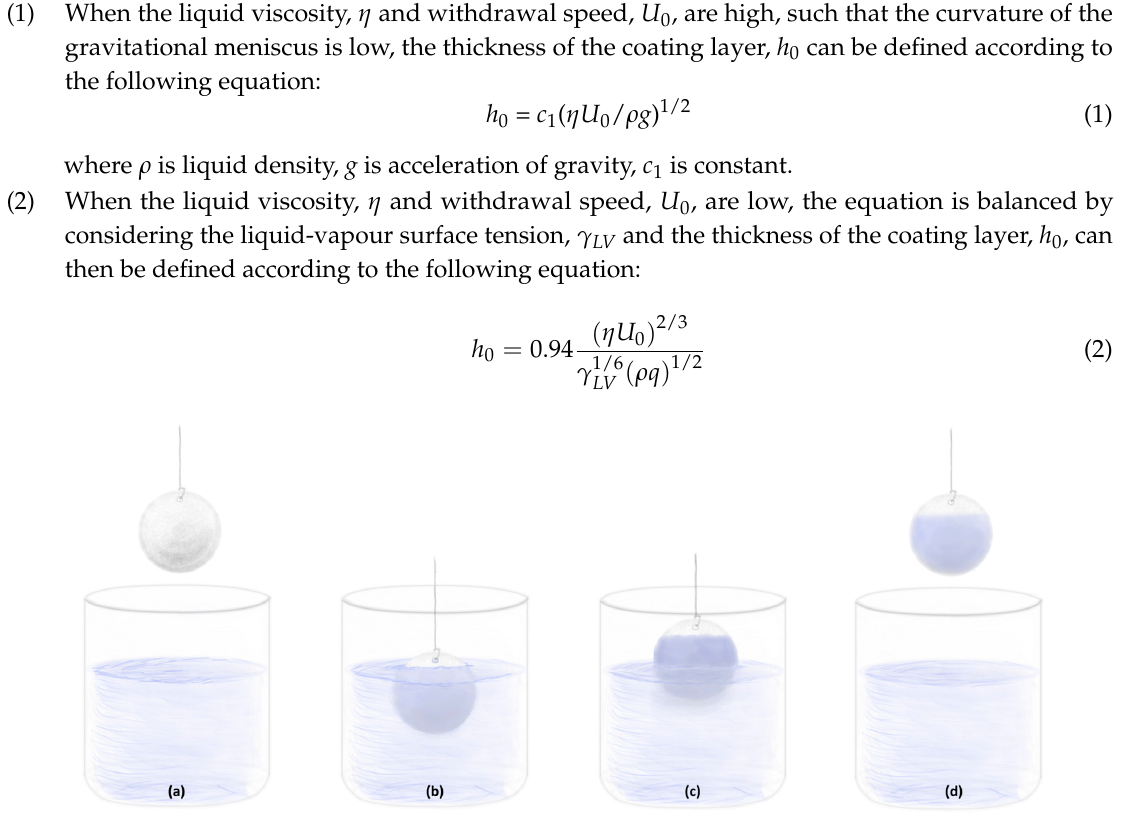
Figure 4. Schematic of the dip-coating technique: ( a ) appropriate presentation of the substrate for the dip-coating procedure; ( b ) immersion of the substrate (optional holding period of the submerged substrate within the coating solution); ( c ) ascent of the substrate from the coating solution; ( d ) fully coated substrate removed from the coating solution.